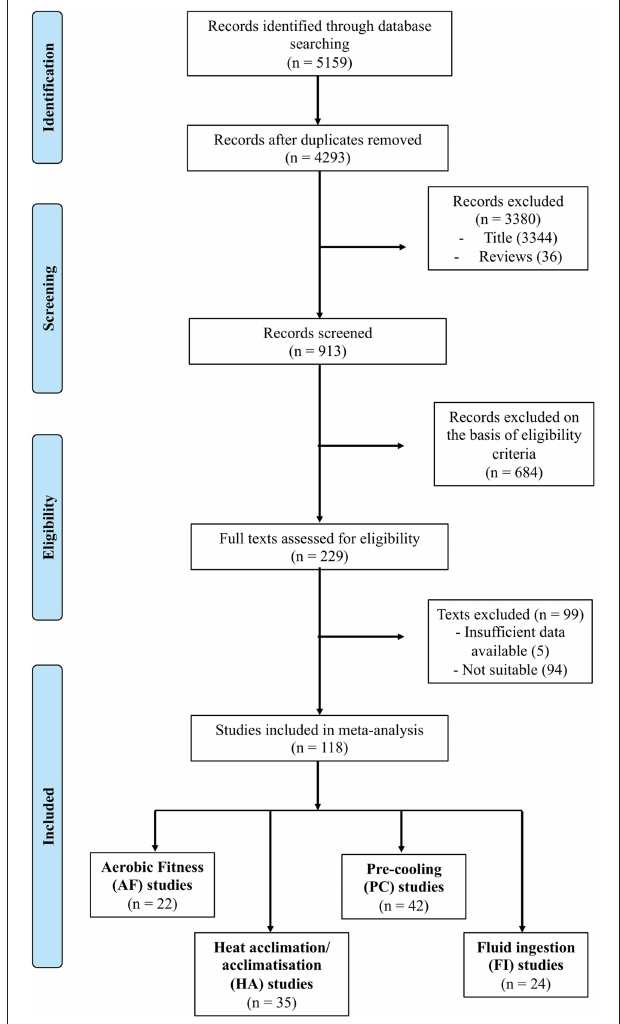
FIGURE 1 | Flowchart of the study selection